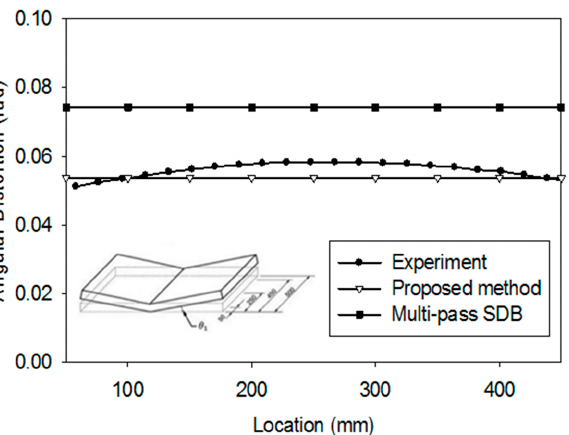
Figure 16. Comparison of angular deformations yielded by each method with the experimental result .